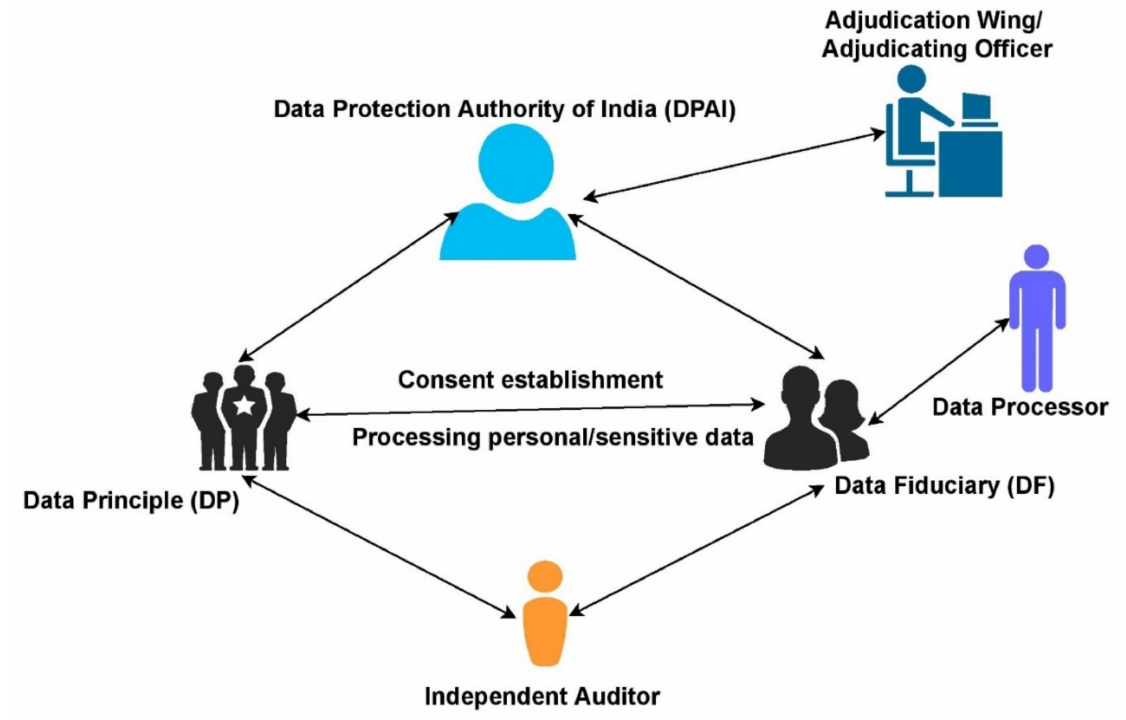
Figure 10. Personal Data Protection bill entities adopted from